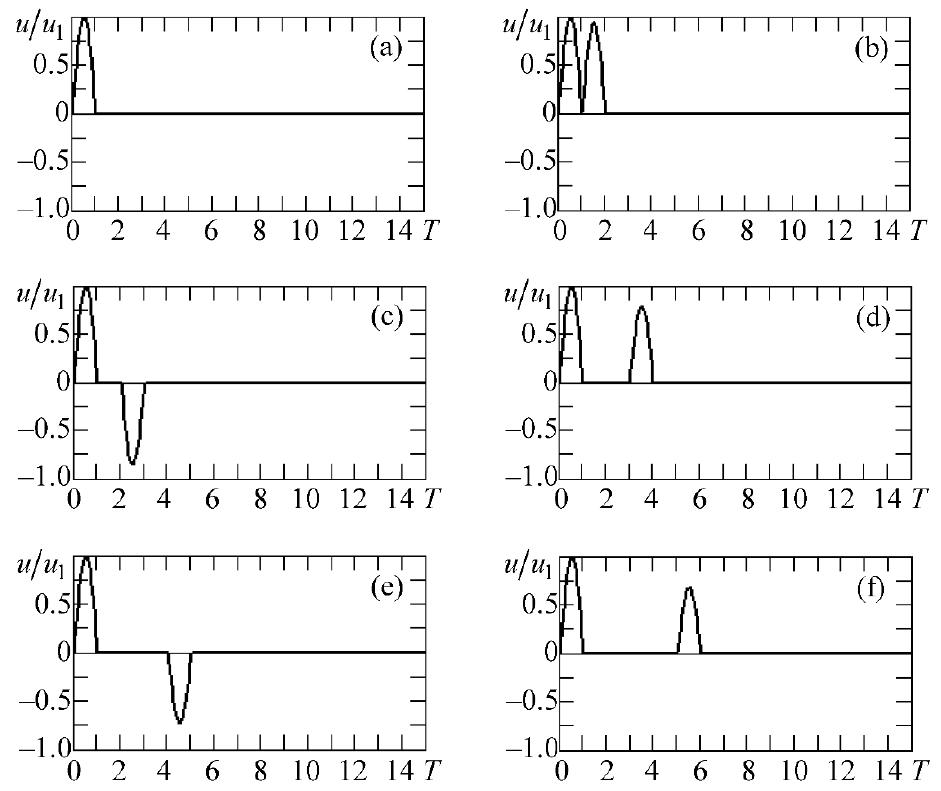
Figure 2. Shapes of electrical signals exciting the radiating piezoelectric plate: ( a ) shows the electric signal consisting of only one (exciting) half-period of the sine wave supplied to the radiator; ( b – f ) shows the electrical pulses (exciting and compensating half-waves).